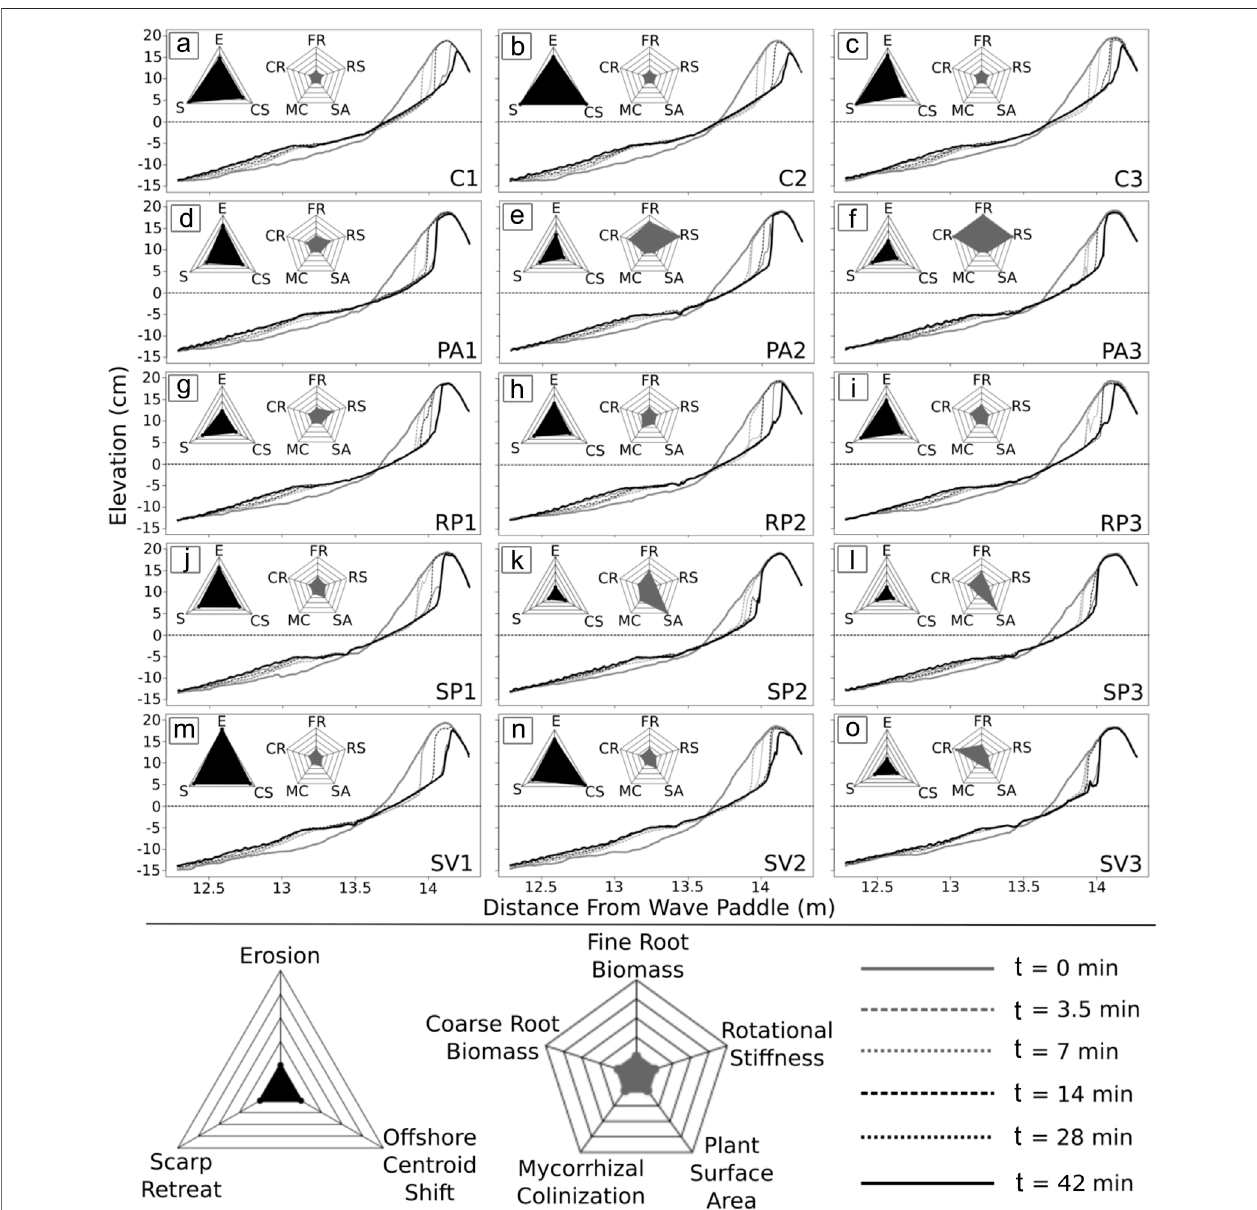
FIGURE5| Evolutionofbeachanddunepro fi lesforallwaveruns.Panelletters (A – O) indicateeachofthe15individualexperimenttrialswithspeci fi ctrialIDgivenin the lower right corner ofeach panel as detailed in Table 1 . Pro fi les are plotted at set timest in minutes as indicated in the legend withthe initial pro fi le depicted asa solid graylineandthe fi nalpro fi leasasolidblackline.Starplotssummarizingbeach/dunemorphologicalchange(threespokes)andplant( fi vespokes)databetweeninitialand fi nal run for each trial are also shown in each panel with individual spoke parameters explained in the legend at the bottom.